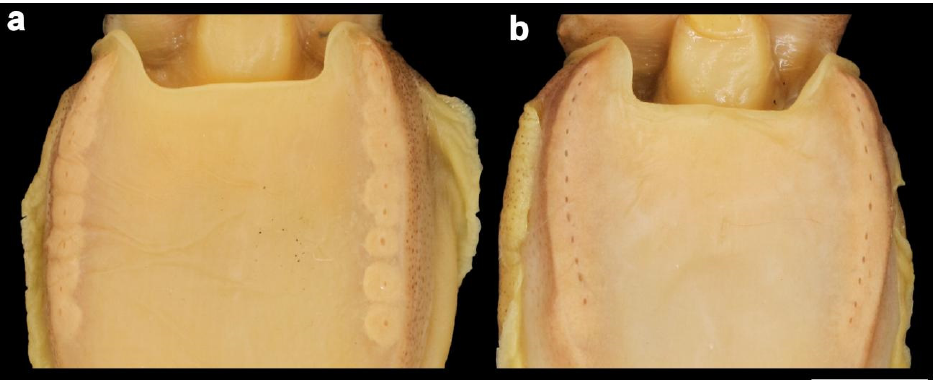
Figure 7. Ventro-marginal glands and pores in Sepia typica : ( a ) SAIAB 211617, male ML 23 mm, with the skin of ventral mantle removed to expose the glands; ( b ) SAIAB 211607, male ML 22 mm, with sub-cutaneous gland positions indicated by pore openings. Scale bar 10 mm.